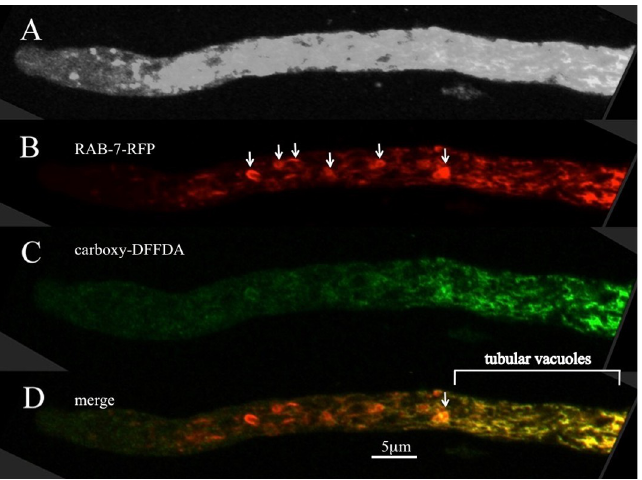
Fig 1. Localization of RAB-7 and carboxy-DFFDA at the hyphal tip. Panel A was intentionally overexposed to show the overall outline of the hyphal tip. Panel B shows the location of RAB-7, tagged with RFP. Arrows point to examples of PVCs. Panel C shows the location of carboxy-DFFDA, largely in the tubular vacuoles in the distal region. Panel D is the merged image for Rab-7-RFP and carboxy-DFFDA.